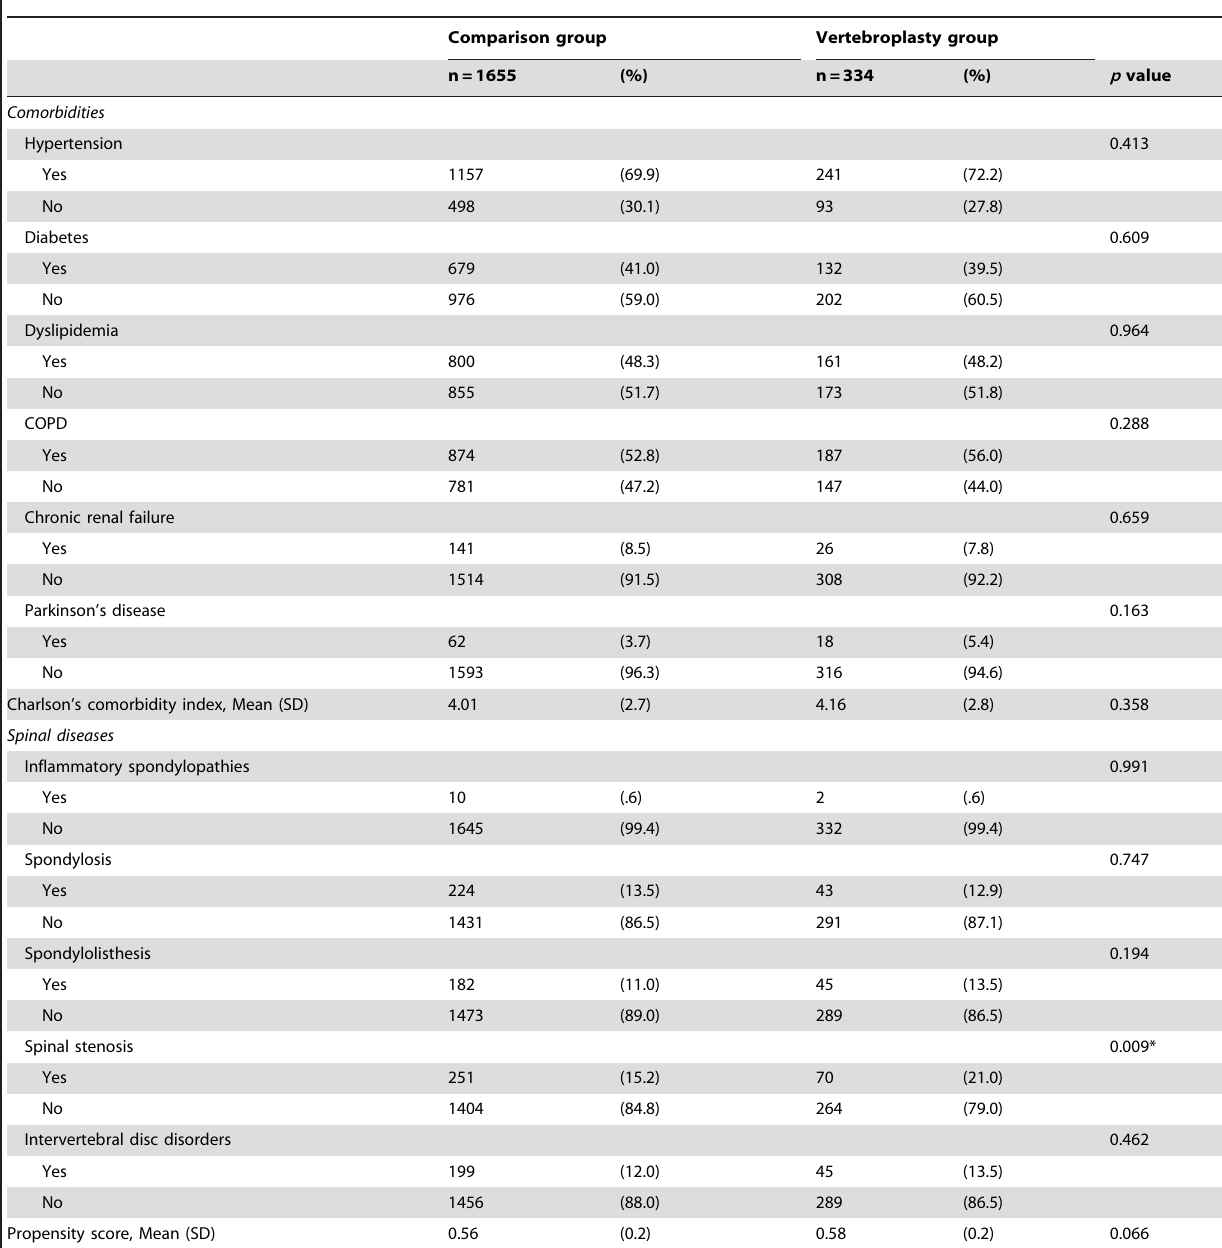
Table 2. Comparison of co-morbidities